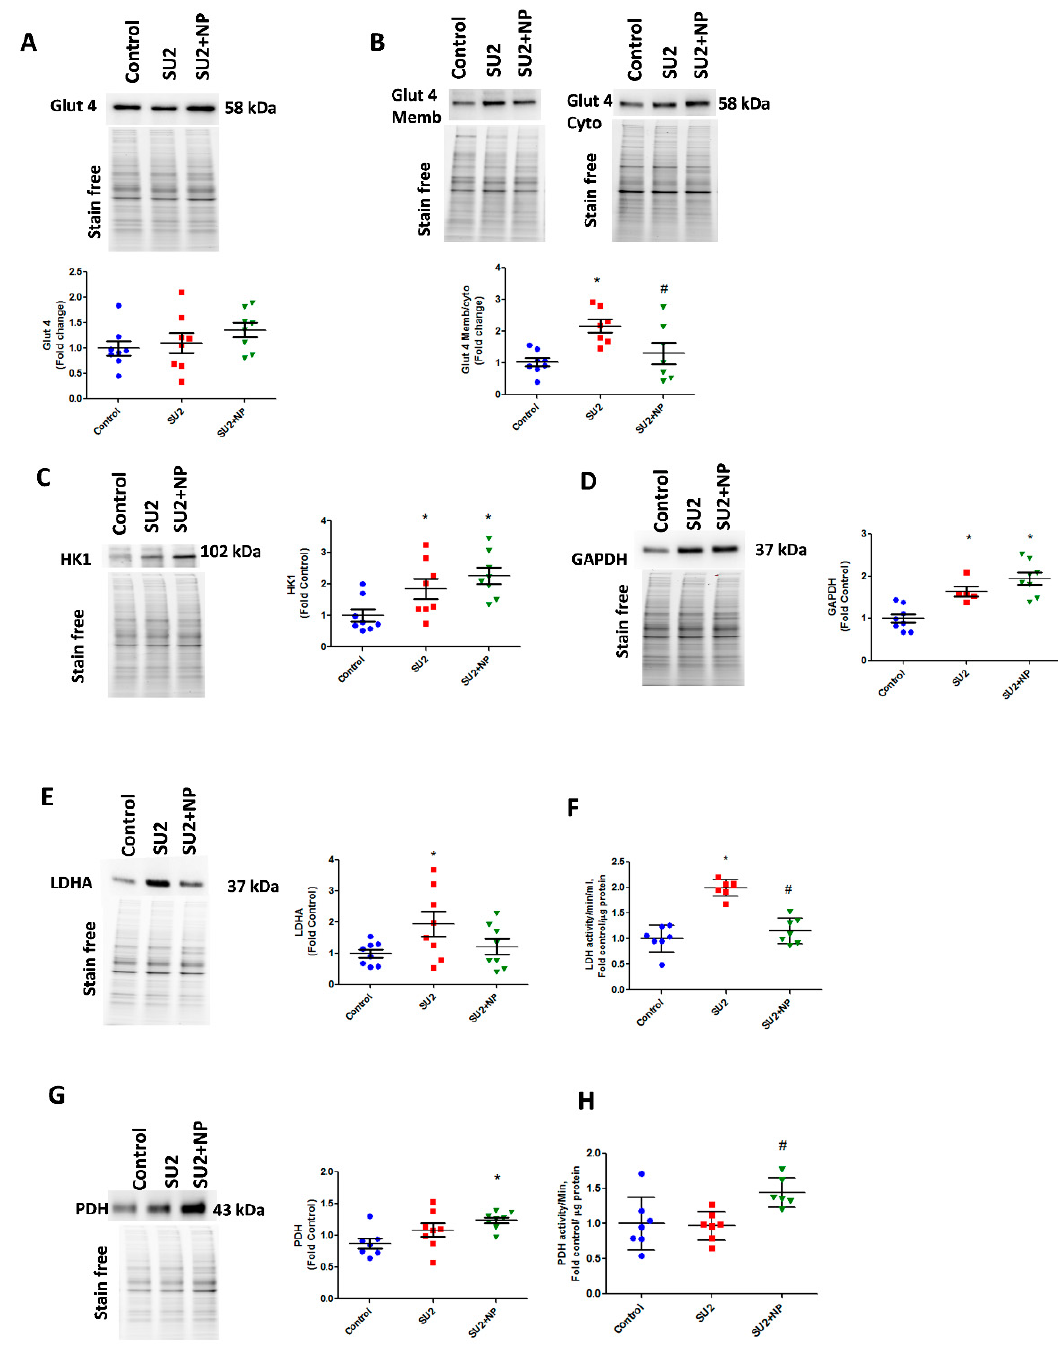
Figure 5. NP treatment balanced glucose influx and glycolysis in PAH. (A ) Western blot of total glucose transporter Glut4 expression in control, SU2, and NP treatment. ( B ) The ratio of Glut4 expression in membrane / cytosol was found significantly increased in SU2, and NP treatment controlled Glut4 translocation. ( C,D ) HK1 and GAPDH expression increased in sugen / hypoxia treatment represents increased glucose utilization by glycolysis. ( E ) Lactate dehydrogenase expression elevated in SU2 represents increased lactate production in early PAH. ( F ) Increased lactate dehydrogenase activity in lung tissue was attenuated with NP treatment. ( G,H ) Pyruvate dehydrogenase expression and activity were found significantly increased in NP-treated sugen / hypoxia. Data expressed as mean ± SE normalized on the total protein, N = 6–8, * p < 0.05 versus control, # p < 0.05 versus SU2 by